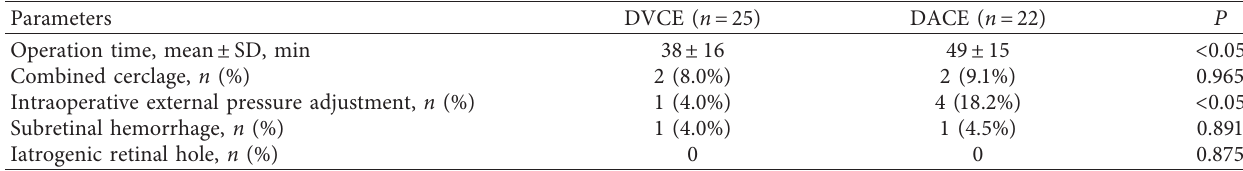
Table 2: Intraoperative characteristics.